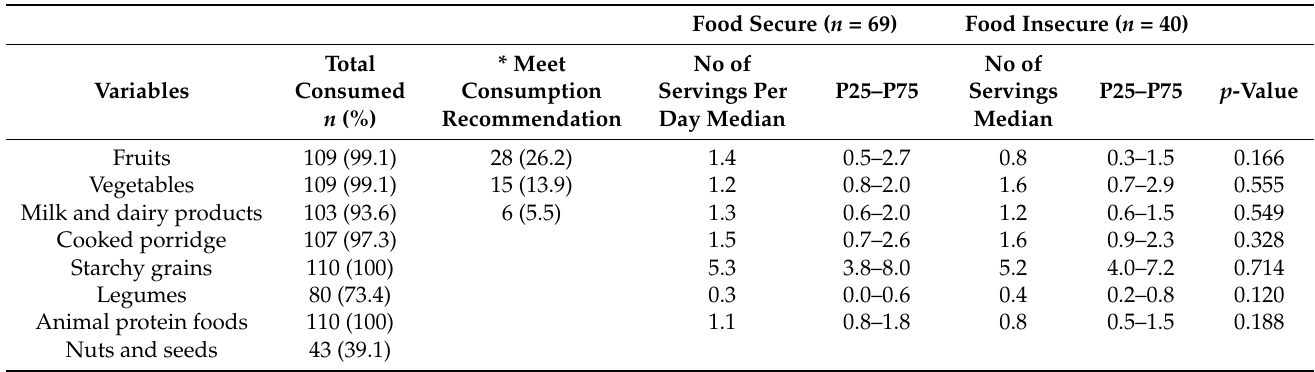
Table 5. Consumption of selected food groups by urban older low-income South African